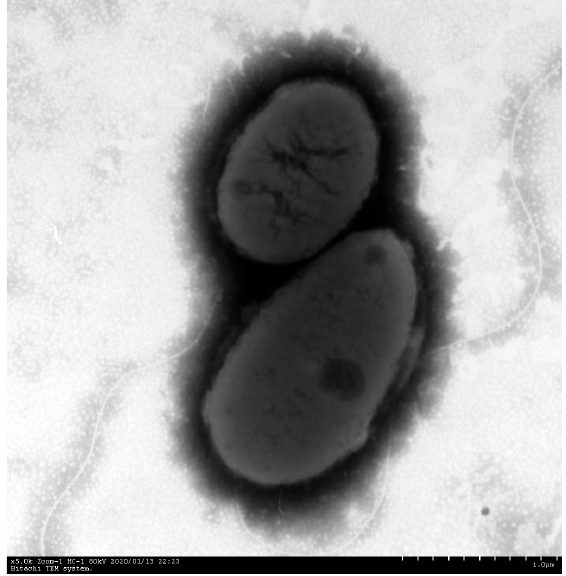
Figure 3. Electron microscope images of the ZZ051 bacterium showed negative staining, a short rod shape, and only one polar flagellum. Scale bar = 1 μ m.